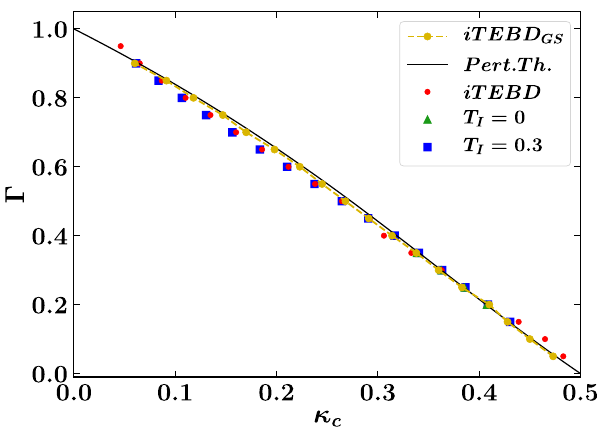
FIG. 11. Phase boundary for the ground-state quantum phase transition separating the ferromagnetic and paramagnetic phases in the ð κ ; Γ Þ plane. Unbiased results for the boundary are obtained using ground-state iTEBD [iTEBD in the legend, obtained GS locating the singularity in ð ∂ 2 e= ∂ κ 2 Þ T ¼ 0 ] and are closely fol- lowed by the predictions of second-order perturbation theory (continuous line). The phase boundary is well described by κ c estimated from the extrema of dC x 1 =d κ obtained in finite-time iTEBD calculations after the quench (for t ¼ 25 ) and in the (expected) long-time thermal results obtained using NLCE. In all quenches κ I ¼ 0 → κ , Γ is not changed during the quench, and we show results for T I ¼ 0 (iTEBD and NLCE) and for T I ¼ 0 . 3